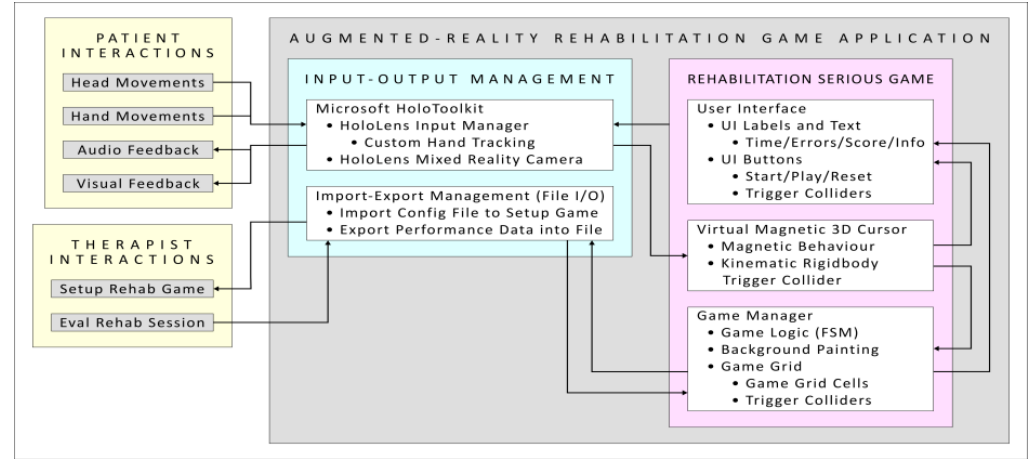
Figure 4. Software architecture of the AR rehab game application, illustrating: the main software modules, the data transfers between modules, and the user types (patients and therapists) with their relative interactions.